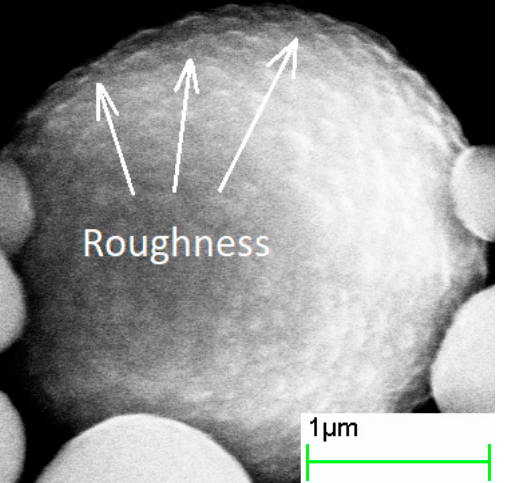
Figure 6. SEM images of core–shell particles obtained in the process with [TEOS]/[NH 3 ·H 2 O] = 4.5 ammonia concentration.